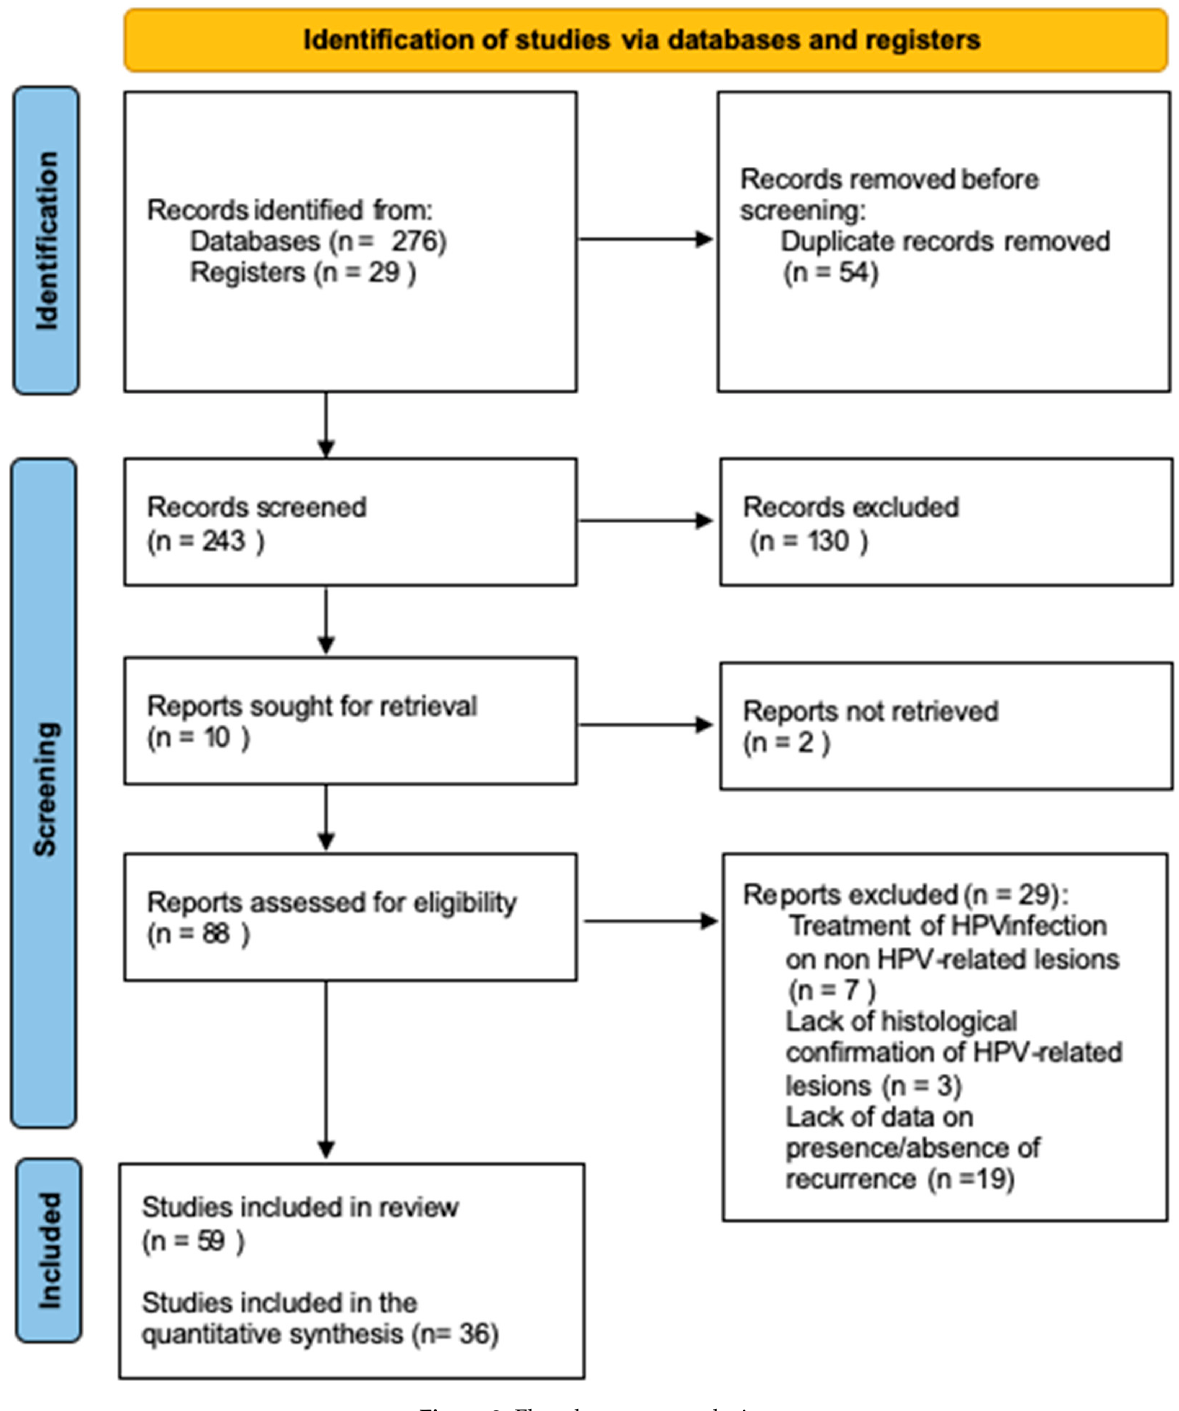
Figure 2. Flowchart